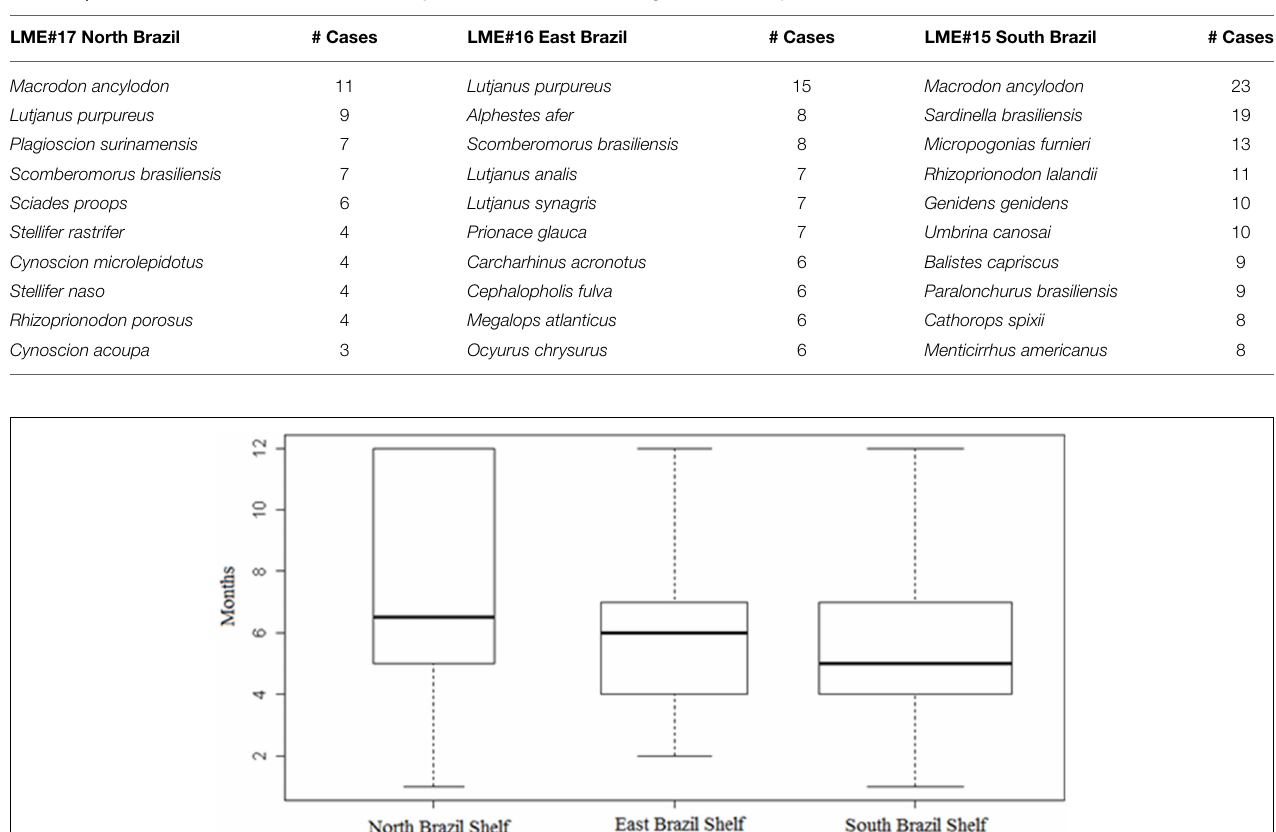
TABLE 2 | Number of cases for the most studied species in each Brazilian Large Marine Ecosystem.